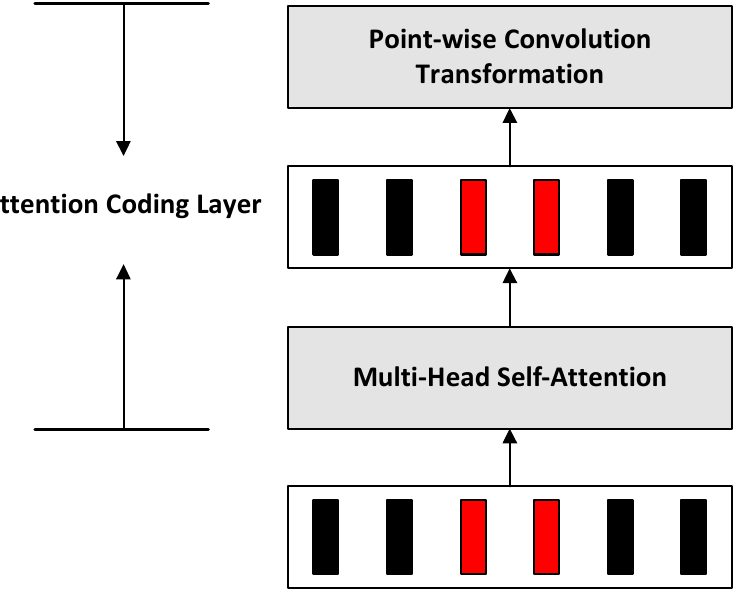
Figure 2. The structure of the Attention Coding Layer.